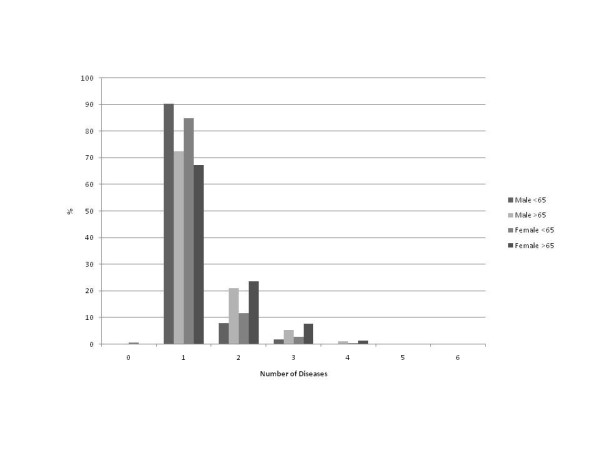
Distribution of disease numbers between genders and age groups.